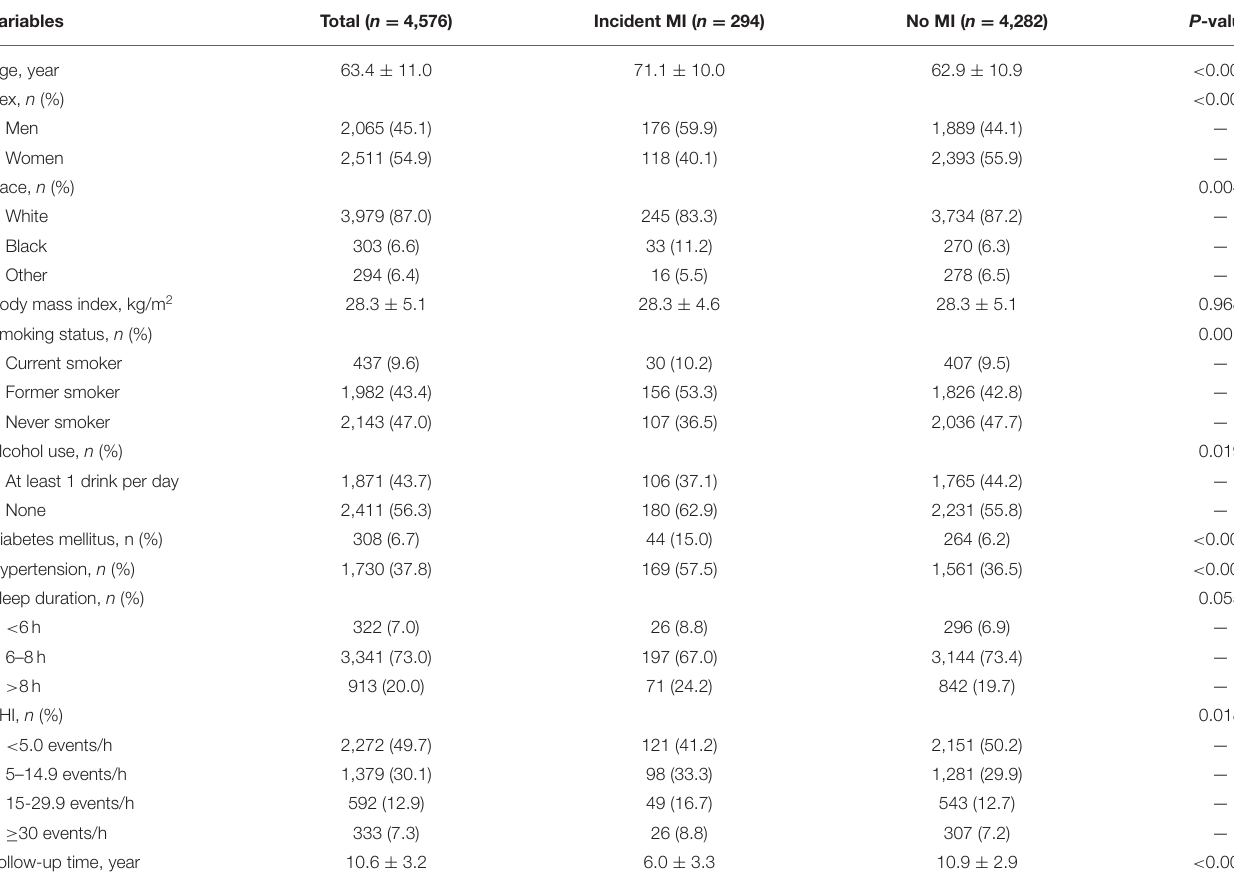
TABLE 1 | Sleep characteristics in participants with or without MI.